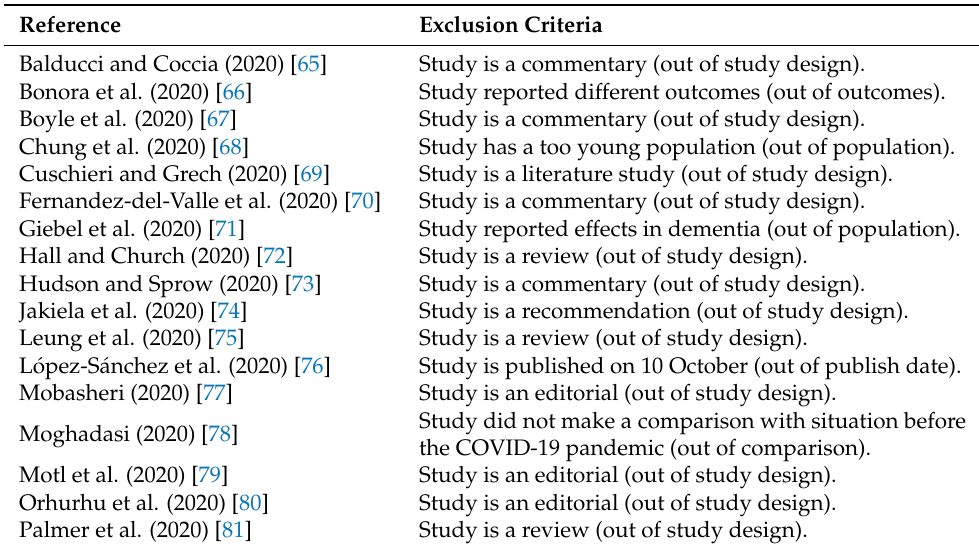
Table A2. List of excluded articles during full-text